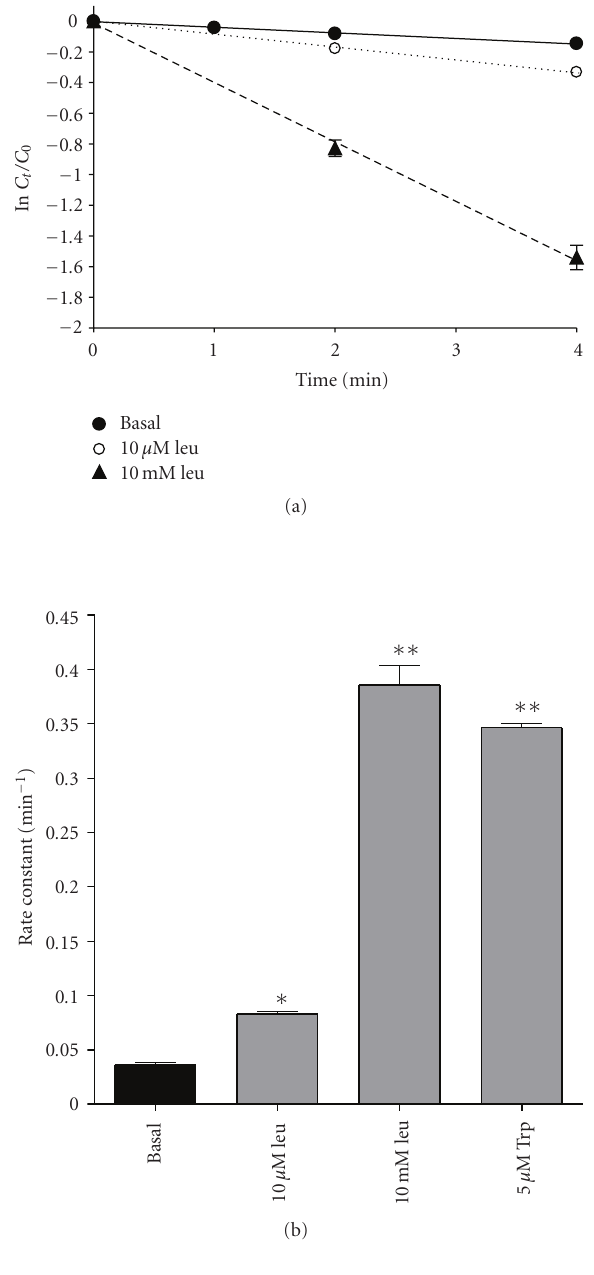
Figure 5: Phenylalanine e ffl ux from 3T3-L1 adipocytes. (a) Time course of phenylalanine e ffl ux showing the trans stimulatory e ff ect of leucine. The cumulative release of [ 3 H]phenylalanine from cells preloaded with the tracer was measured in the presence or absence of extracellular leucine over the time period indicated. Values are shown ± SEM for 6–18 measurements (smaller error bars are obscured by symbols). C 0 represents the cellular radioactivity at the start of the experiment and C t is that at time t , as calculated from the sum of cumulative radiotracer appearance in the medium and residual cellular radioactivity. The rate constant for e ffl ux was taken as the gradient of the line of best fit. (b) E ff ects of external amino acids on rate constant for phenylalanine e ffl ux. Bars indicate rate constants calculated as described in (a) and error bars represent SEM for gradient of the line of best fit. ∗ P < . 05, ∗∗ P < . 01; value significantly di ff erent from basal